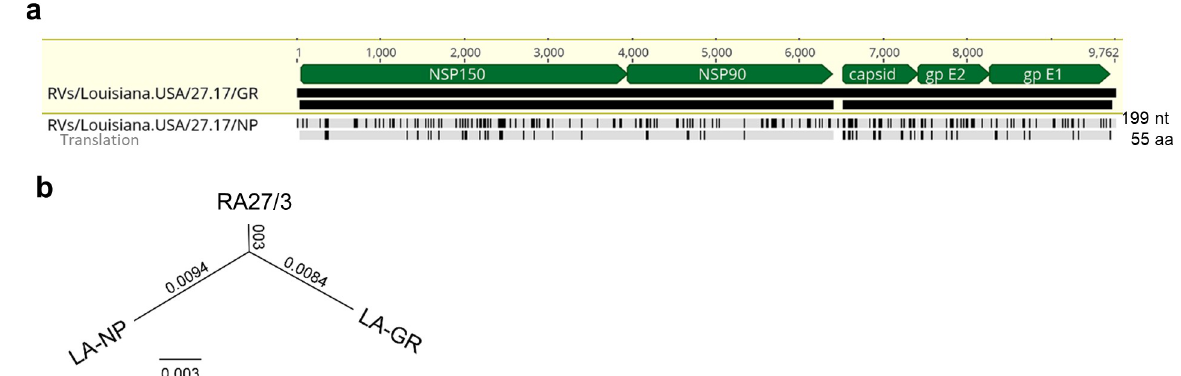
Fig 5. Different iVDRV lineages in different body sites (arm skin and NP). a. Divergence of the iVDRV sequence in the NP fluids relative to iVDRV in the skin granuloma. Nucleotide and amino acid substitutions in the NP-derived sequence relative to granuloma-derived sequence (shaded in light yellow) are depicted as vertical lines. The number of substitutions are shown at the right side. The positions of encoded proteins in the genomic sequence are indicated by green pointed bars. b . Neighbor-Joining phylogenetic tree showing the genetic relationships between the whole genome sequences of RA27/3, LA-NP and LA-GR viruses. The genetic distances were computed using the Maximum Composite Likelihood method. The scale bar indicates the number of base substitutions per site.